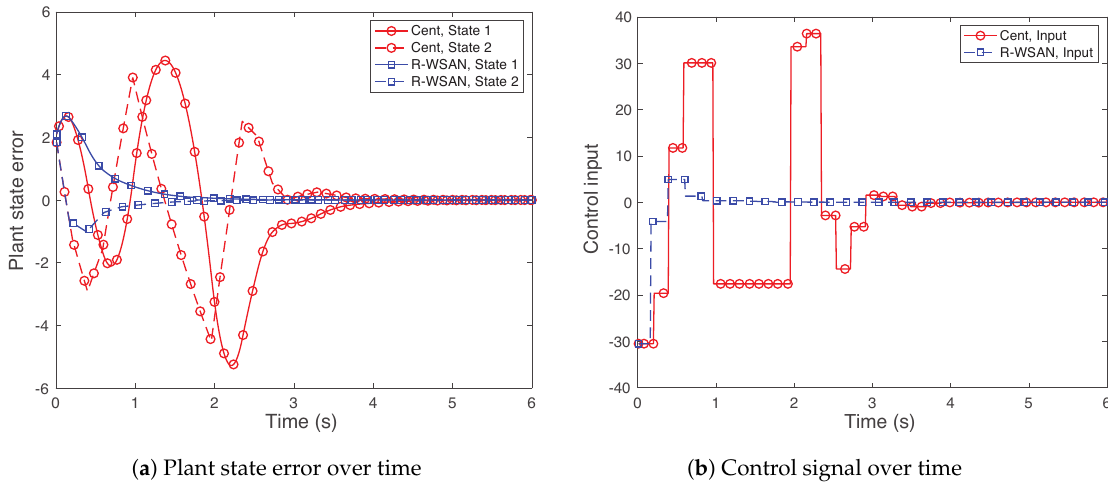
Figure 10. Step response of the control systems against the intra-cluster failure. R-WSAN provides the reliable control performance without any significant overshoot.